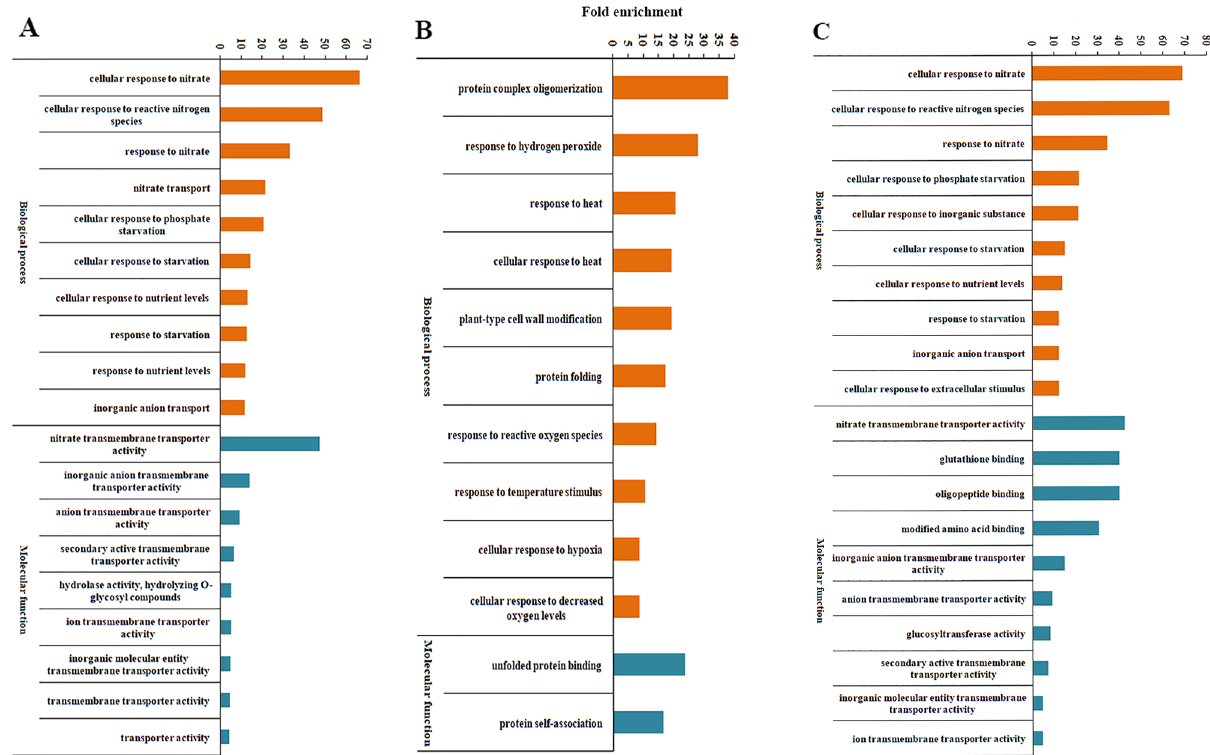
Figure 4. Gene ontology analysis of genes differentially expressed in HA ( A ) RAR ( B ) and HA + RAR ( C ) treatment. Gene ontologies were categorized by their